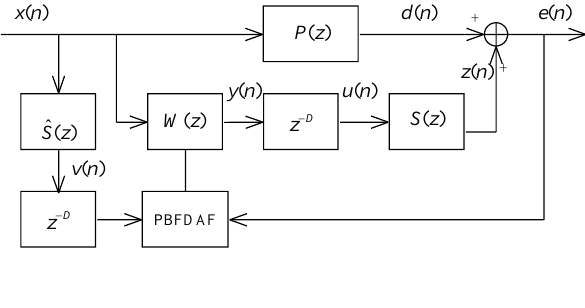
Figure 2. FPBFxLMS